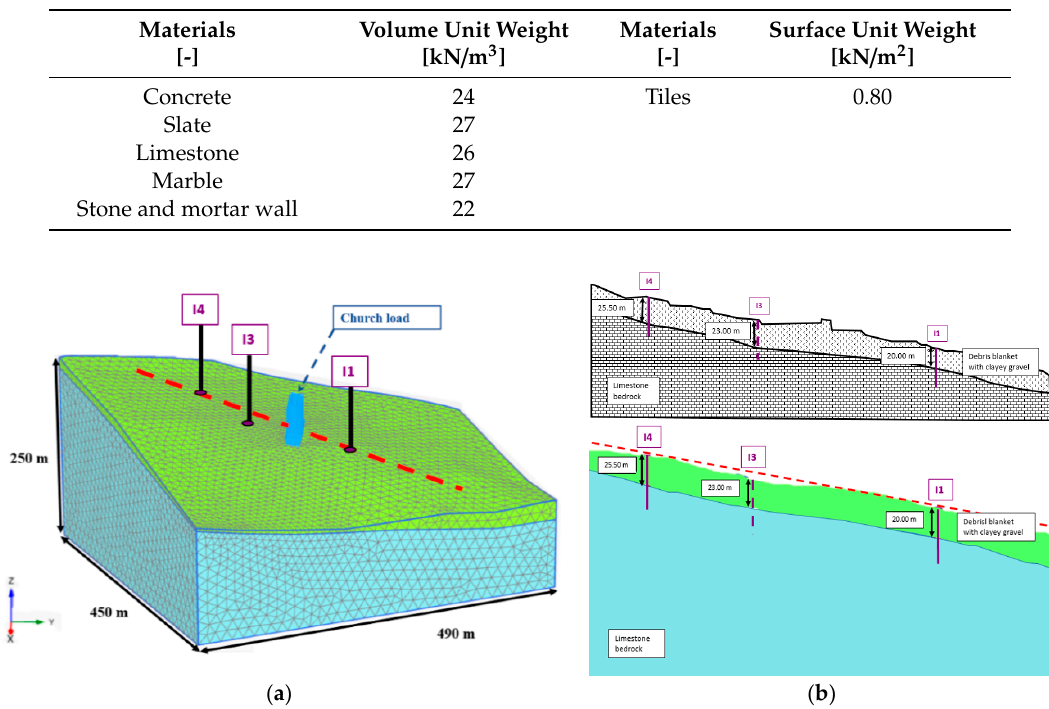
Figure 11. ( a ) 3D model of the slope with the church load; ( b ) Comparison between the detected stratigraphy profile (image above) and the numerical model cross-section (image below).